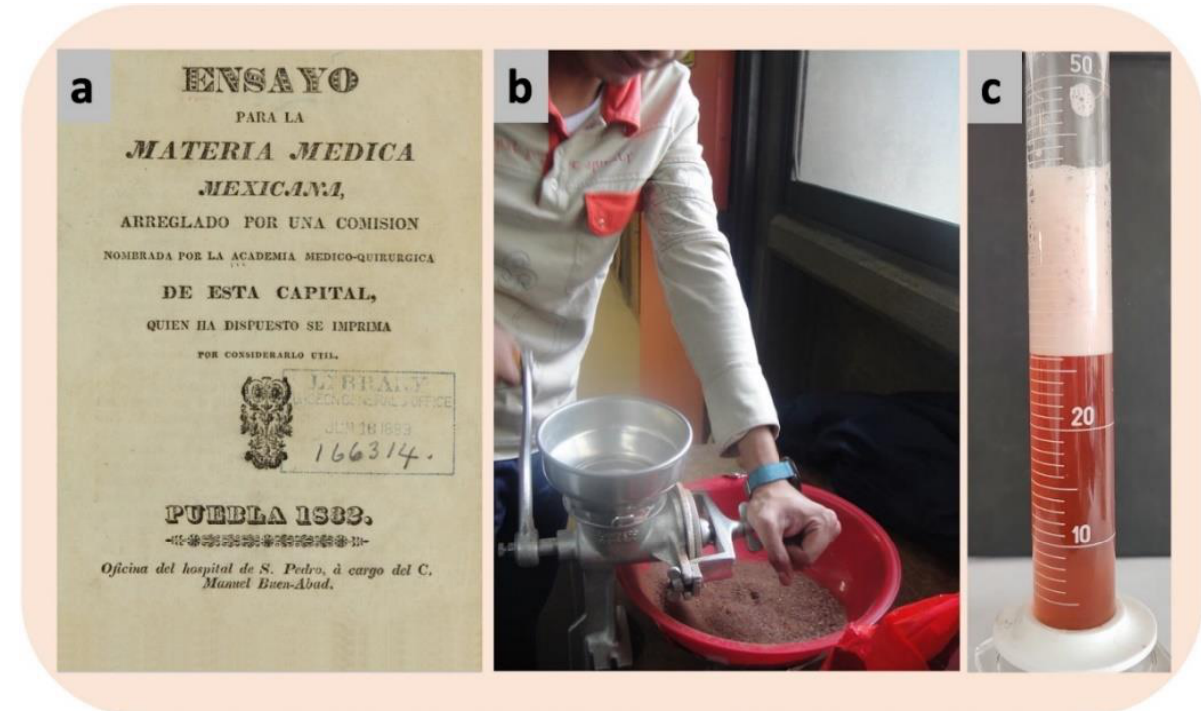
Figure 5. Primary modes of widespread use of the stem bark of A. adstringens for the treatment of diseases or injuries. ( a ) The Essay on Mexican Materia Medica is one of the first manuscripts where the medicinal use of the plant is reported (https://archive.org/details/61540040R.nlm.nih.gov/page/n3/mode/2up; accessed on 1 July 2022); ( b ) pulverized stem bark and ( c ) boiled aqueous extract of the stem bark with the production of foam (after shaking) that is indicative of the presence of saponins.